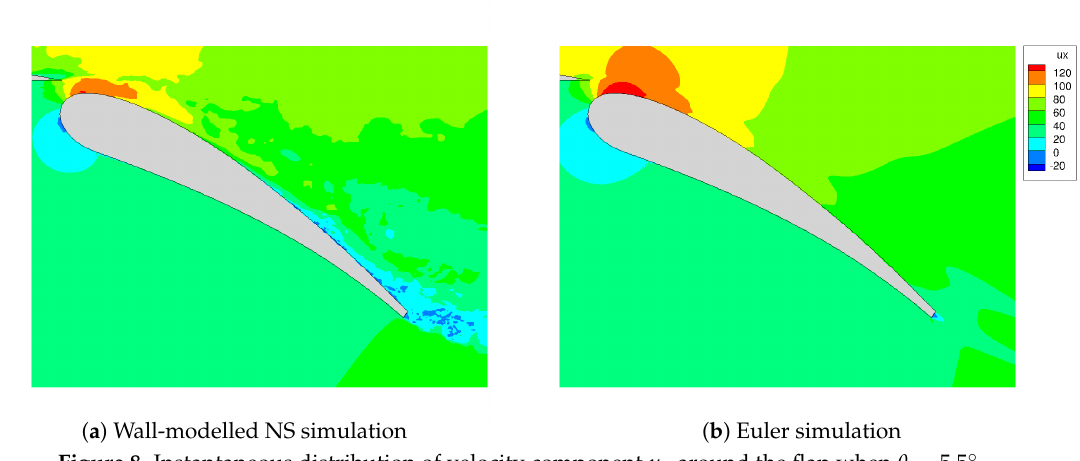
Figure 8. Instantaneous distribution of velocity component u x around the flap when θ = 5.5 ◦ . Flow separation occurs on the suction side of the upstream side of the trailing edge of the flap in the instantaneous flow field as shown in Figure 8a. It does not reattach before the trailing edge of the flap. In contrast with Figure 8b, the flow does not separate in the time-averaged flow field (Figure 9). This indicates that the separation near the trailing edge of the flap occurs intermittently. The lift coefficients in this study and the θ -sweep of that in the experiment in Reference [23] are shown in Figure